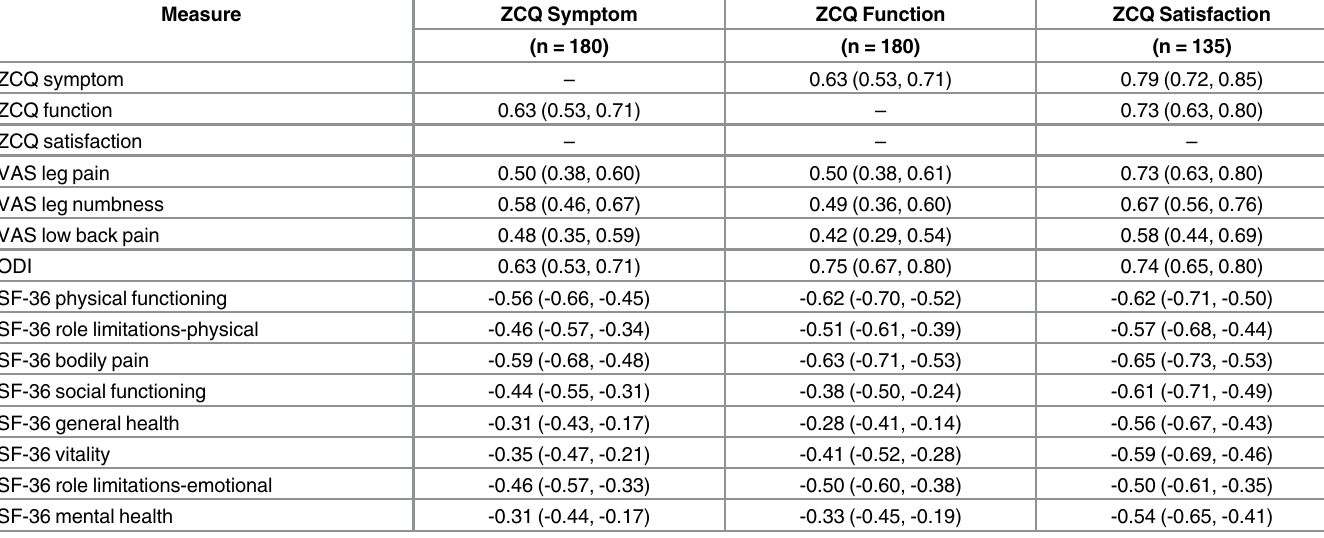
Table 3. Spearman ’ s correlation coefficients (95% confidence interval) between the ZCQ and the ODI, VAS, and SF-36v2.